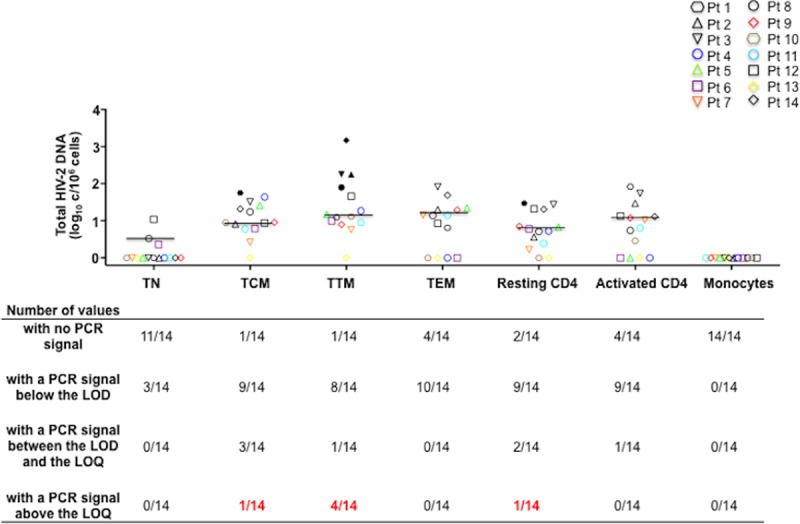
The distribution of total HIV-2 DNA was quantified in various sorted populations from peripheral blood mononuclear cells (PBMCs) from 14 HIV-2 infected subjects.Total HIV-2 DNA quantification in CD3-CD4-CD14+ Monocytes, CD25+CD69+HLADR+ activated CD4 T-cells and CD25-CD69-HLADR- resting CD4 T-cells sub-sorted into: naive (TN; CD45RA+CCR7+CD27+) central-memory (TCM; CD45RA-CCR7+CD27+) transitional memory (TTM; CD45RA-CCR7-CD27+) and effector-memory cells (TEM; CD45RA-CCR7-CD27-). Results are expressed as the log10 HIV-2 DNA copies per million cells, and medians are shown. Each symbol represents a subject. Filled symbols show quantifiable DNA detection. The limit of detection (LOD) of the HIV-2 DNA assay is 3 copies/PCR and the limit of quantification (LOQ) is 6 copies/PCR.